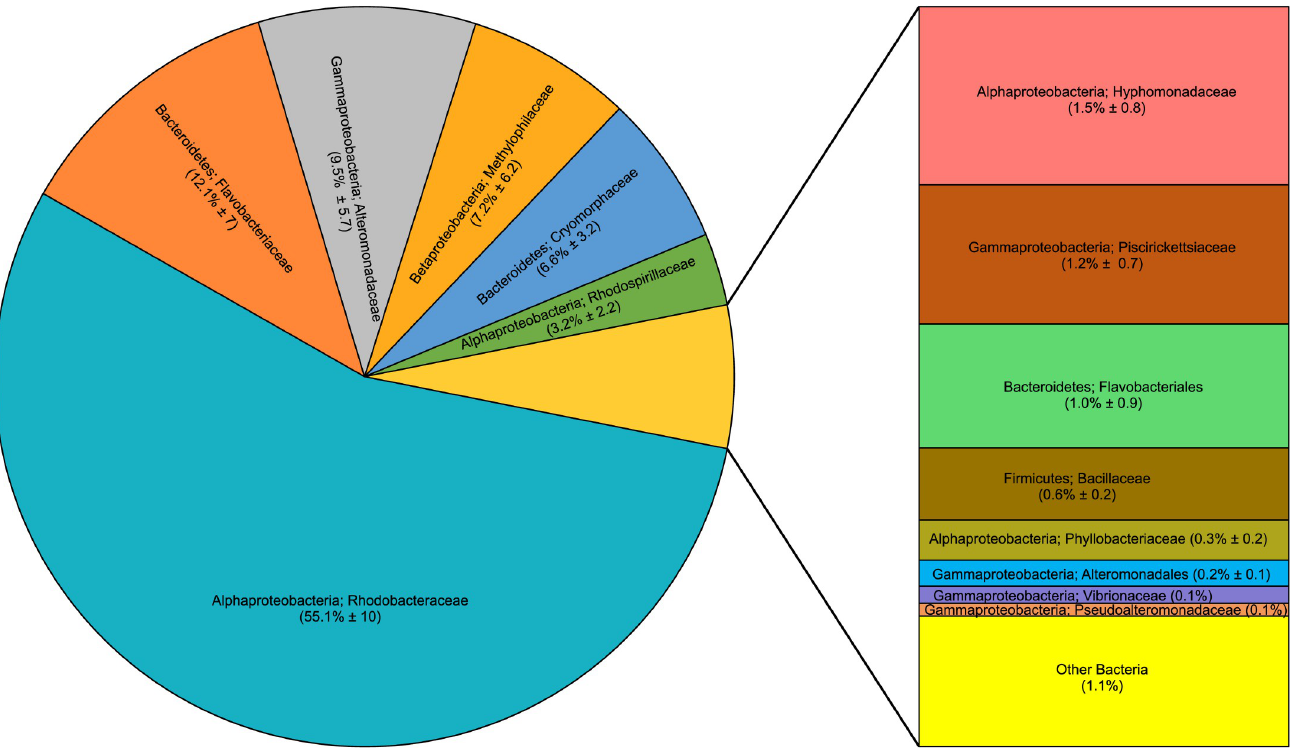
Fig 8. Microbiome community structure of Odontella sp. cultures using 16S rDNA amplicon sequencing. The relative abundance of OTUs summarized at the family level is shown. Microbiome members that are � 0.1% (average relative abundance of n = 4) were included in the figure. Families with � 0.1% were grouped as “Other Bacteria”. Rhodobacteraceae , to which Sulfitobacter is a member, and Flavobacteriaceae , to which Polaribacter and Cellulophaga are members, were the top two abundant families in the Odontella microbiome. Vibrionaceae , to which Vibrio is a member, and Pseudoalteromonadaceae , to which Pseudoalteromonas is a member, were rare in the microbiome assemblage. Planococcoceae , to which Planococcus is a member, was not detected in the Odontella microbiome.